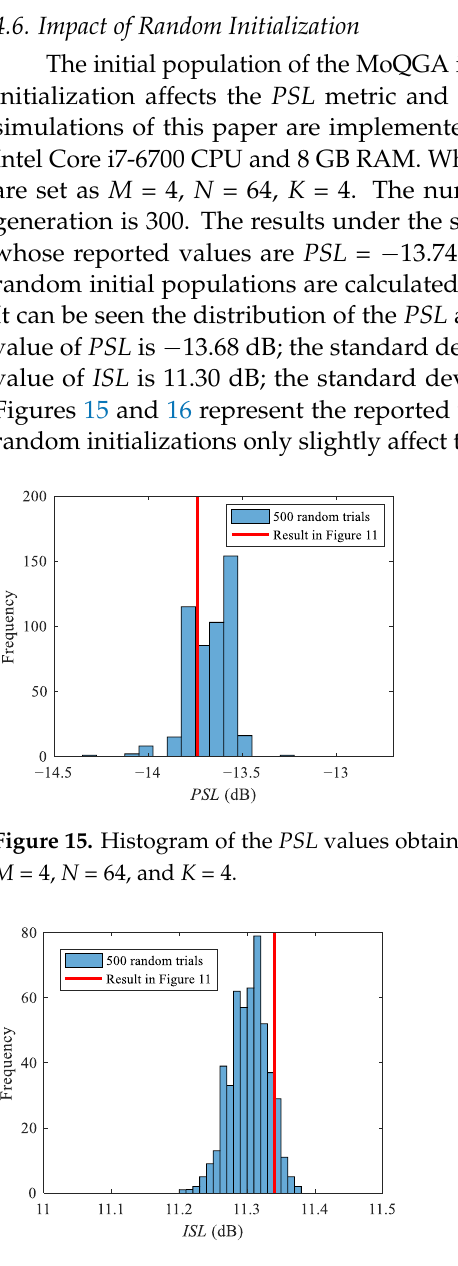
Figure 14. PSL values of MIMO radar poly-phase code sequence set obtained by MoQGA and other methods when M = 4 and N = 32.